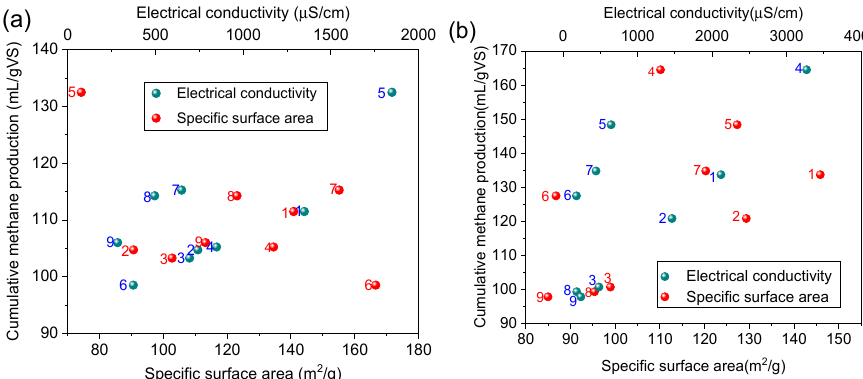
Figure 8. The relationship between ABC properties and cumulative methane production of ( a ) CABC and ( b ) PABC. and ( b )